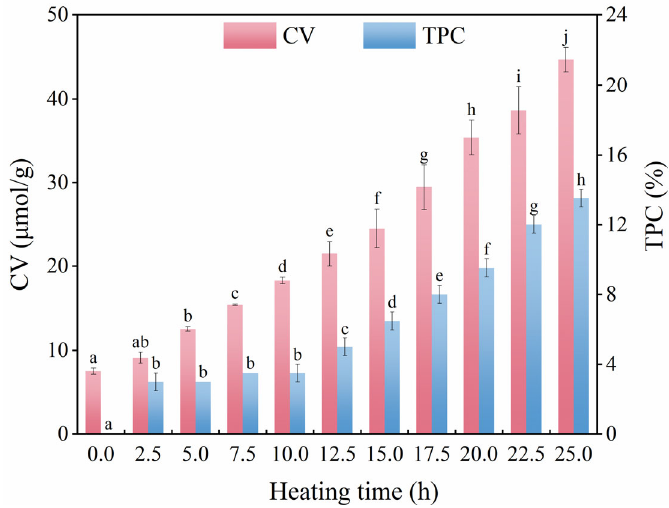
Figure 1. Change in carbonyl value (CV) and total polar compounds (TPC) level during frying. Different superscript letters in the same color column indicate significant differences ( p < 0.05).